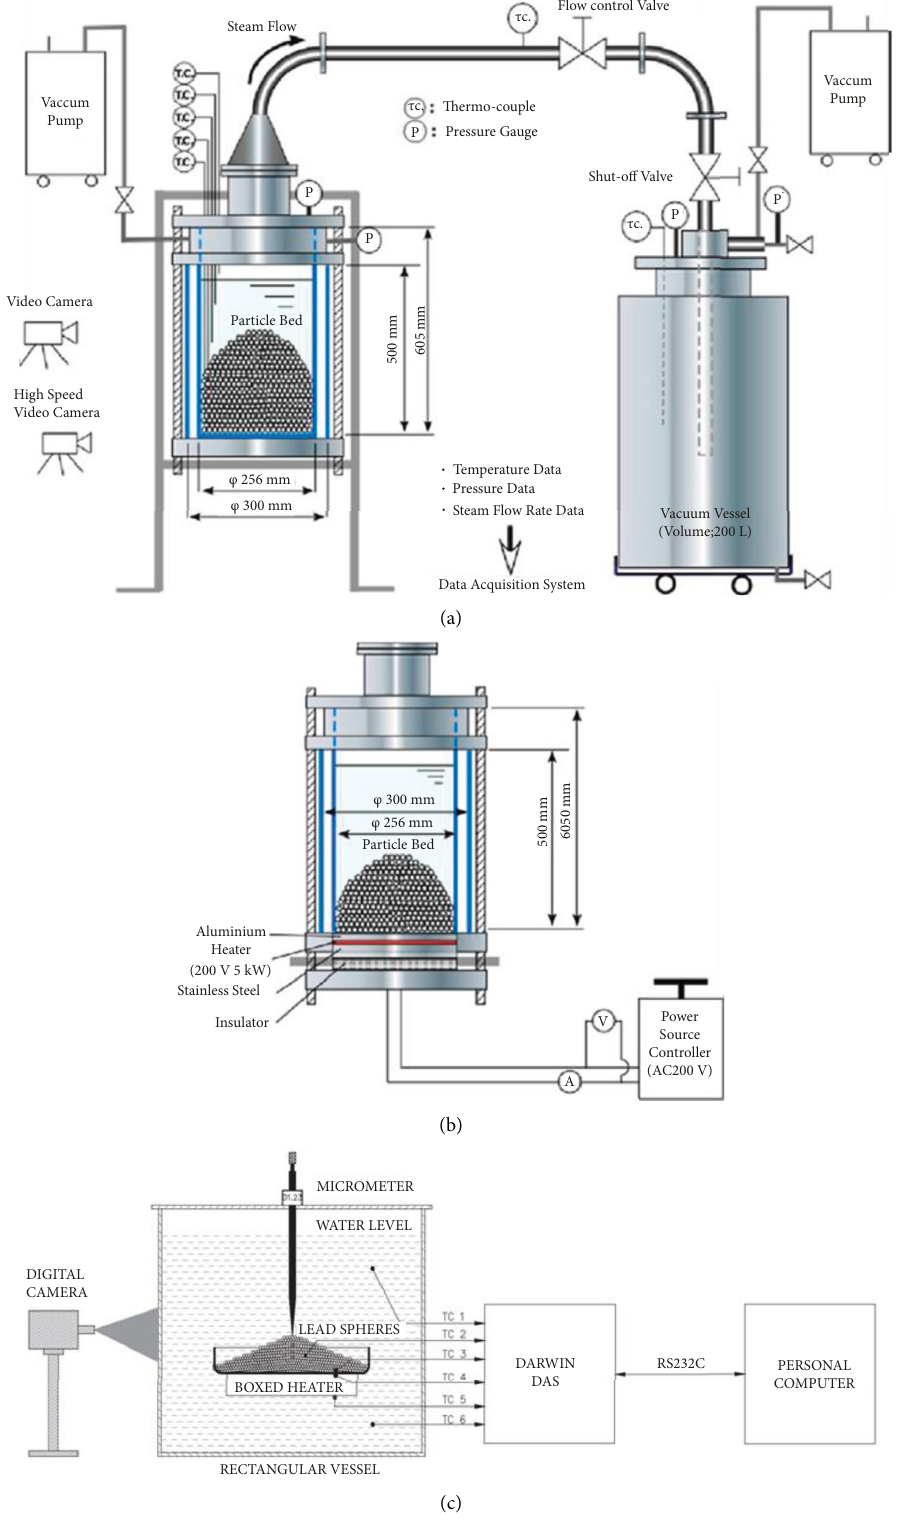
Figure 8: Self-leveling experimental systems with boiling methods [10, 30] (a) Depressurization boiling condition (b) Bottom-heated boiling condition (Kyushu University and JAEA) (c) Bottom-heated boiling condition